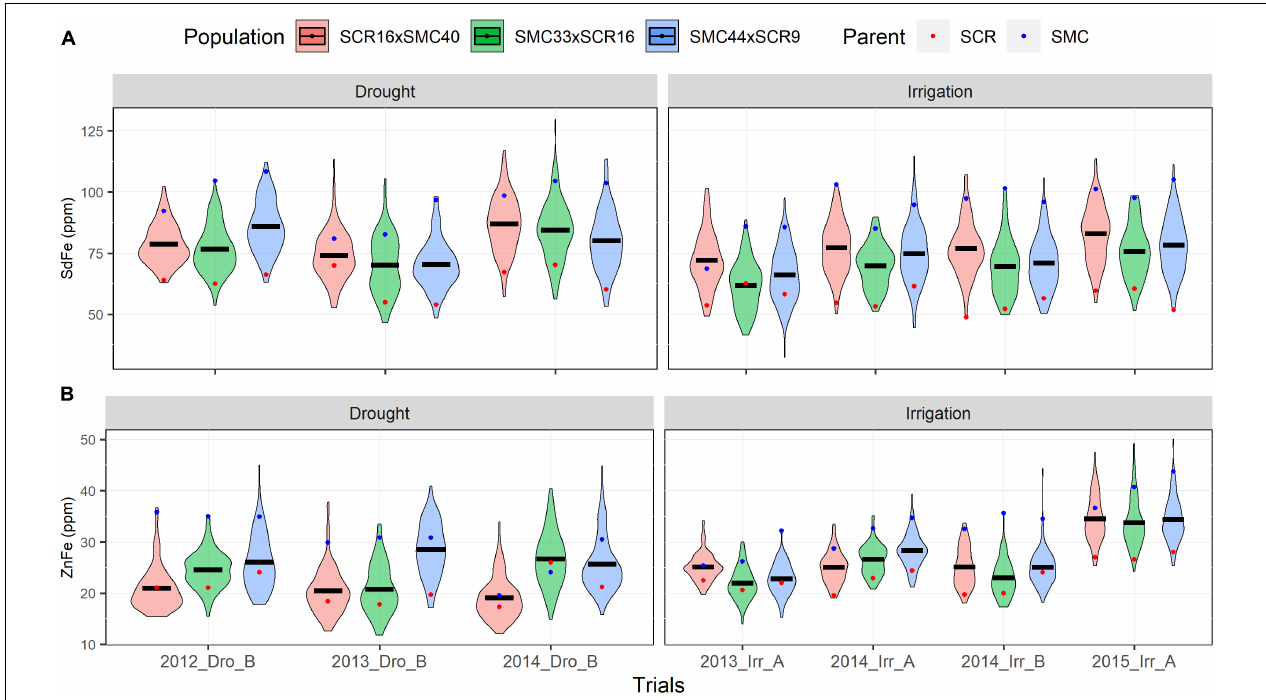
FIGURE 1 | Phenotypic distribution of micronutrients content traits. Fe accumulation (SdFe) (A) and Zn accumulation (SdZn) (B) evaluated of 2012, 2013, 2014, and 2015 under drought and irrigated conditions for the SCR16 × SMC40, SMC33 × SCR16, and SMC44 × SCR9